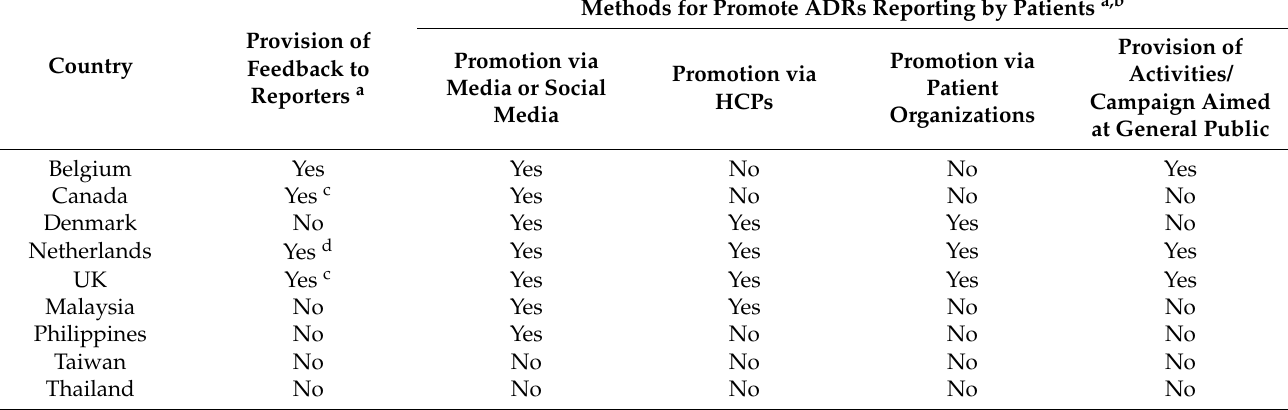
Table 8. Activities regarding adverse drug reaction reporting by